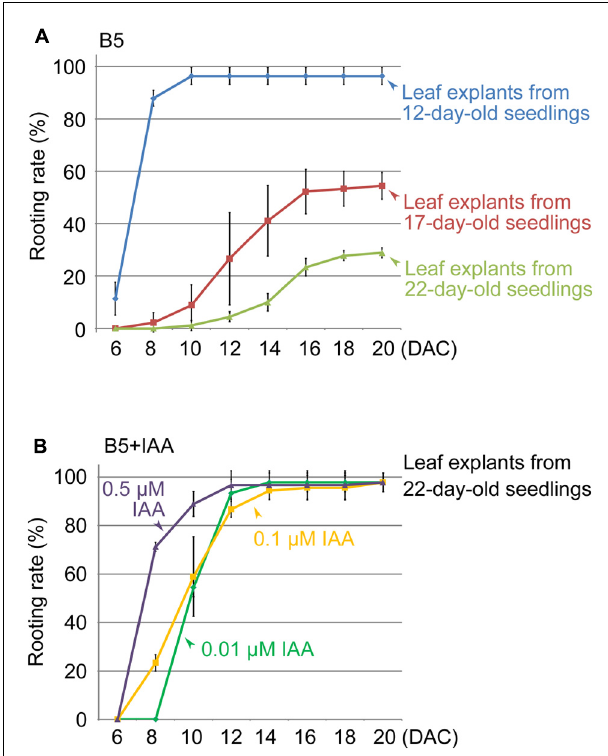
FIGURE 2 | Effects of leaf age and auxin concentration on rooting rate of leaf explants. (A) Rooting rate of leaf explants from 12-, 17-, and 22-day-old seedlings. (B) Effect of IAA in B5 medium to rescue rooting defect of leaf explants from 22-day-old seedlings. Bars show s.d. with three biological repeats. N = 30 in each individual